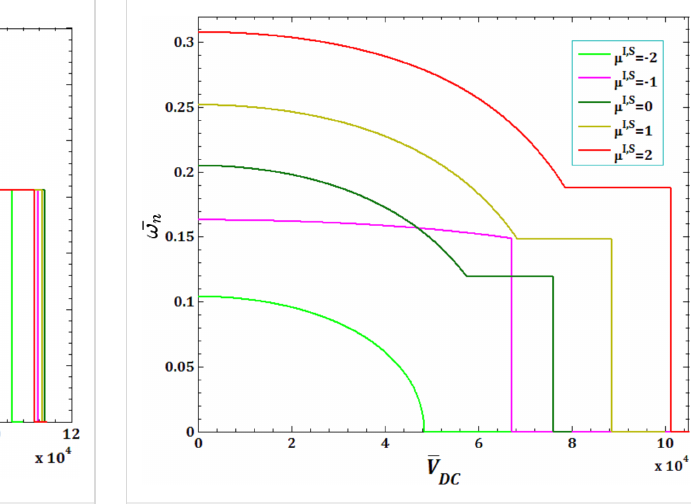
Figure 6: The effects of surface/interface Lame’s constants λ I,S for pull-in voltage on DNF of SS FC-MWPENS.